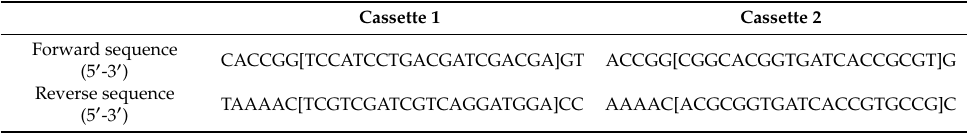
Table 1. Hsp70 guide RNA ([gRNA]) and overhangs (guide RNA